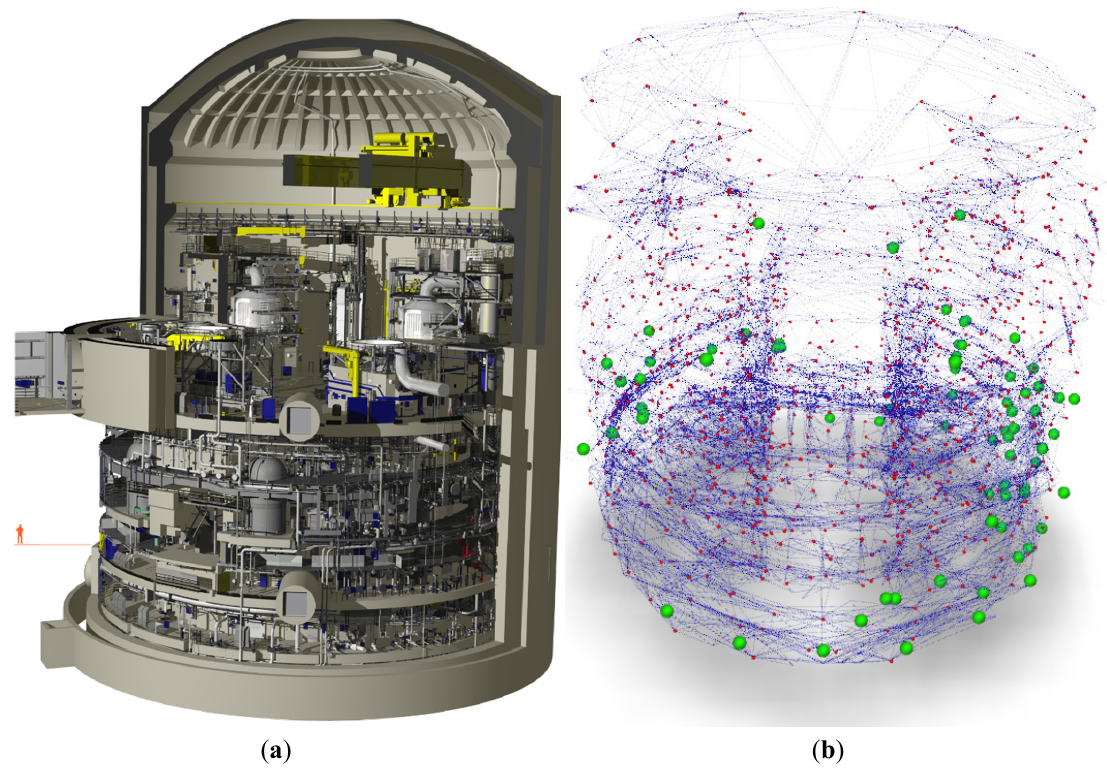
Figure 5. ( a ) Scale of the reactor in a power plant facility, a cylindrical building with 11 floors; ( b ) 1000+ TLS stations and targets for referencing appear as a very complex 3D network: green spheres are reference points; red spheres are TLS stations; and blue lines are the sights of registration targets from TLS stations.